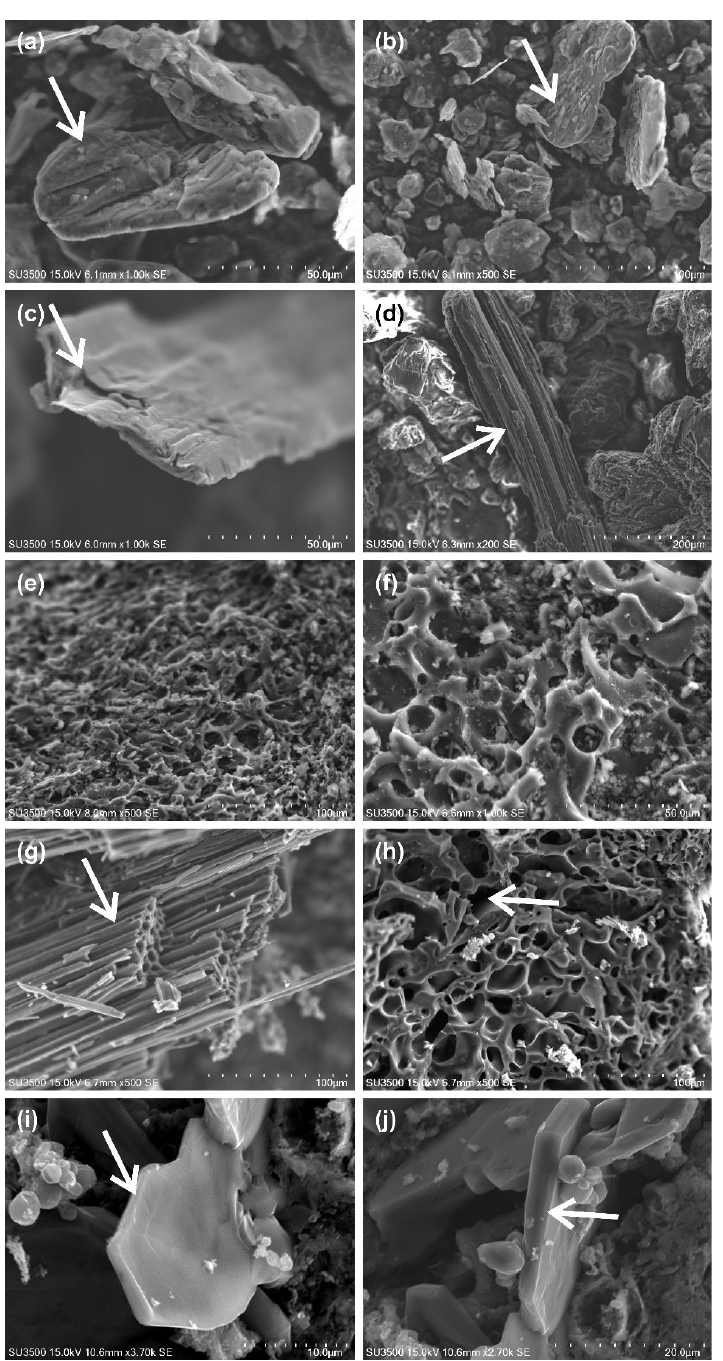
Figure 3. The morphology of particles in SEM images: ( a , b )—plate form of graphite in sample GN; ( c , d )—plate form of graphite in sample GS; ( e , f )—unburned carbon before graphitization in sample Carbonizate 85; ( g , h )—tubes form unburned carbon after graphitization in sample Carbonizate 85_2400; ( i , j )—plate form similar to hexagonal shape after graphitization in sample Carbonizate 85_3000; the arrow points to the morphological form being described.